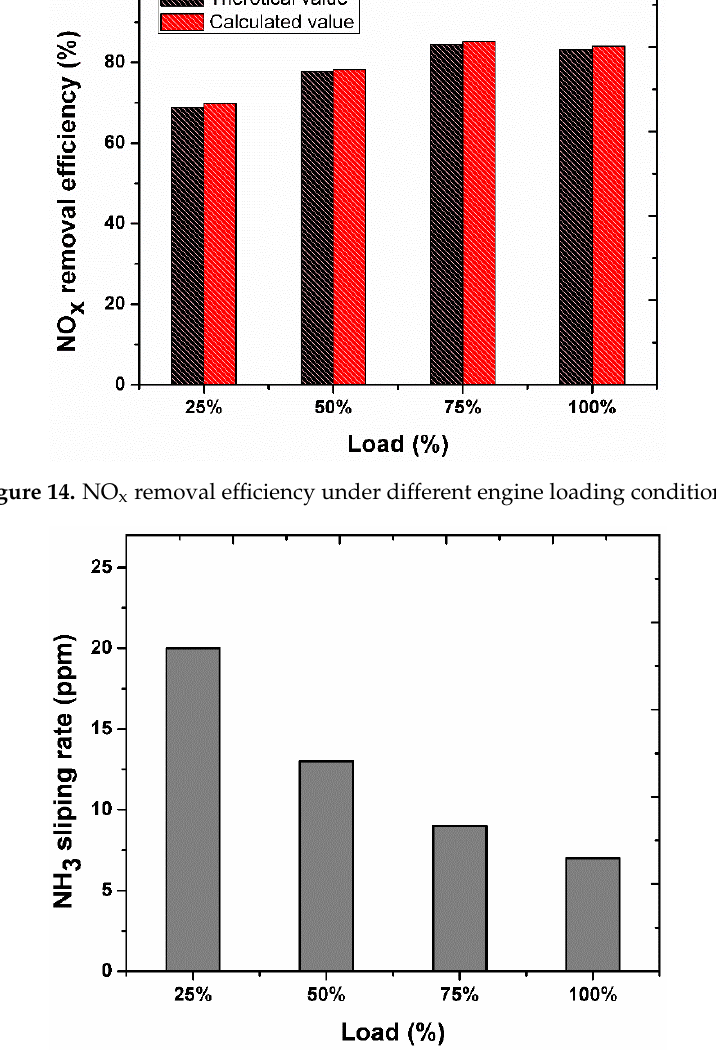
Figure 15. NH 3 escaping rate under different engine loading conditions.